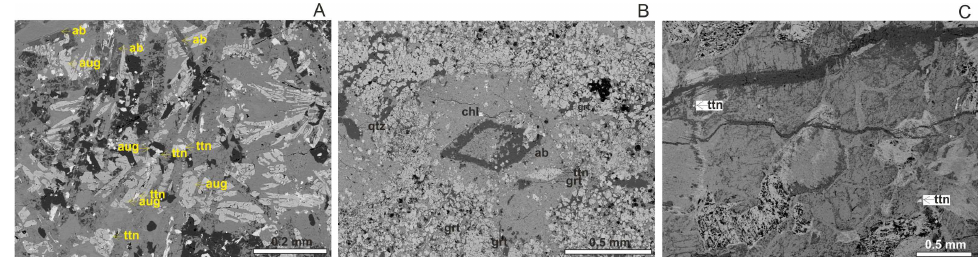
Figure 2. Typical textural features of titanite at the studied locations. ( A ): Disseminated, fine grained anhedral titanite in basalt (Nagy-Rézoldal Quarry, BSE image). ( B ): Coarse grained, euhedral titanite in hydrothermal mineral formed crystal aggregate in strongly altered basalt (Kétvíz Hill SE, BSE image). ( C ): Disseminated, fine grained anhedral titanite in altered gabbro (Thirra, BSE image by courtesy of